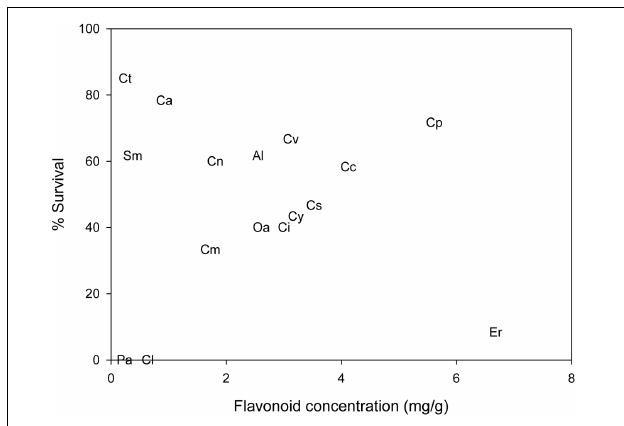
FIGURE 4 | Mean flavonoid concentration and percent survival of Cassida rubiginosa on 16 Cardueae test species. The relationship between % survival and flavonoid concentration is not significant. Ct, Carduus tenuiflorus ; Ca, Cirsium arvense ; Cp, Cirsium palustre ; Cv, Cirsium vulgare ; Sm, Silybum marianum ; Al, Arctium lappa ; Cn, Carduus nutans ; Cc, Cynara cardunculus ; Cs, Cynara scolymus ; Cy, Centaurea cyanus ; Ci, Centaurea nigra ; Oa, Onoporodum acanthium ; Cm, Centaurea macrocephala ; Er, Echinops ritro ; Pa, Ptilostemon afer ; Cl, Carthamus lanatus .